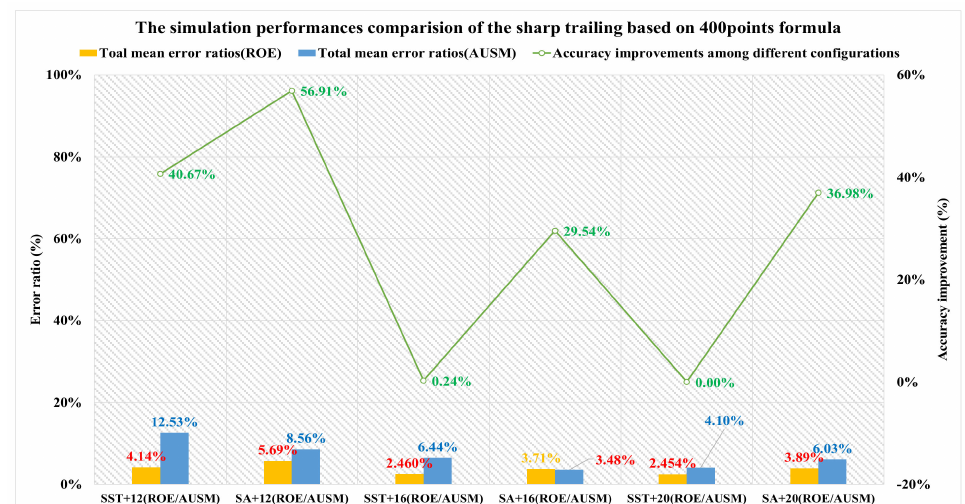
Figure 22. Comparison of the simulation performances of the sharp trailing edge based on 400 points formula under different simulation